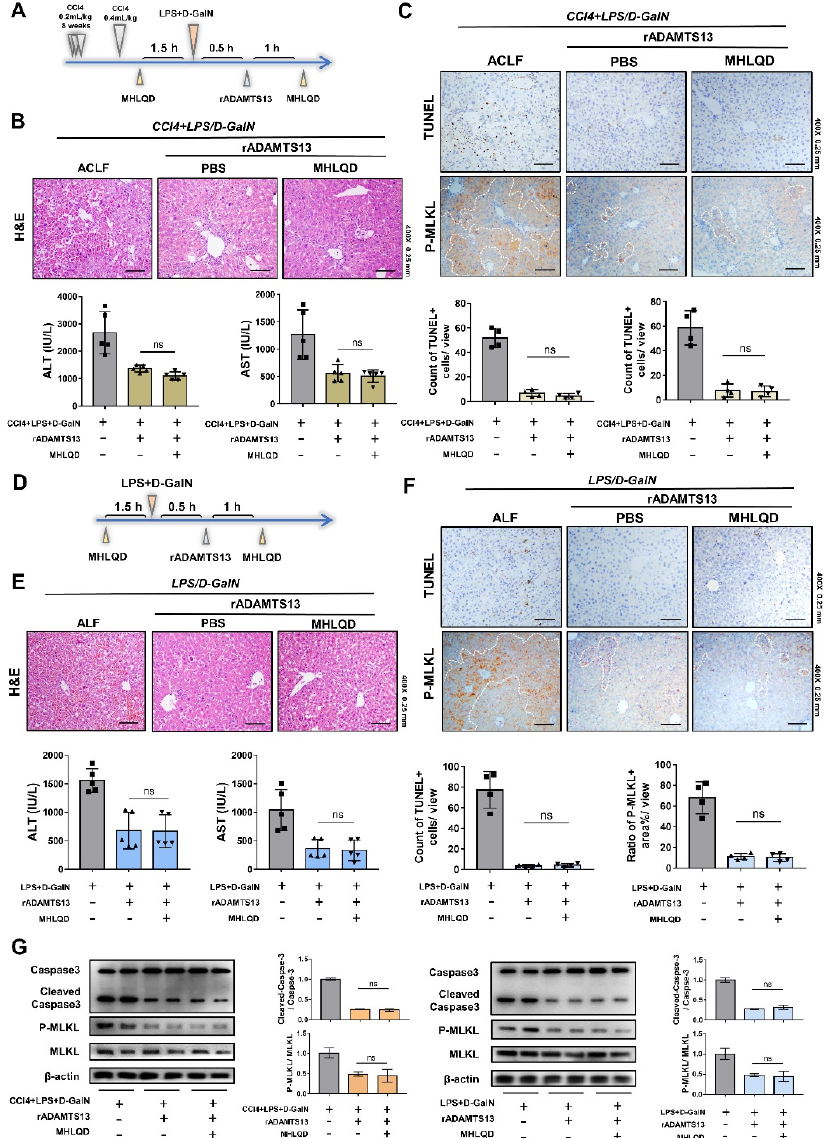
Figure 6. The therapeutic effect of MHLQD could not be replicated in VWF inhibitor-treated